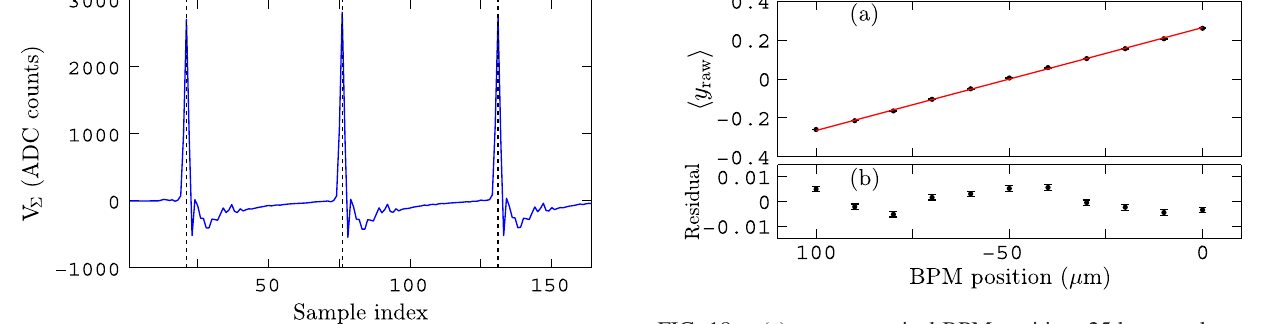
FIG. 18. (a) y vs vertical BPM position. 25 beam pulses are raw averaged at each setting; the red line is a linear fit to the data. (b) Residual of the data with respect to the fitted line. The maximum deviation of the residuals corresponds to ∼ 2 μ m, and is consistent with periodic beam drift over the course of a few minutes.